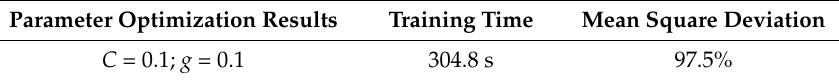
Table 3. Results of establishment and training of the model experiment.